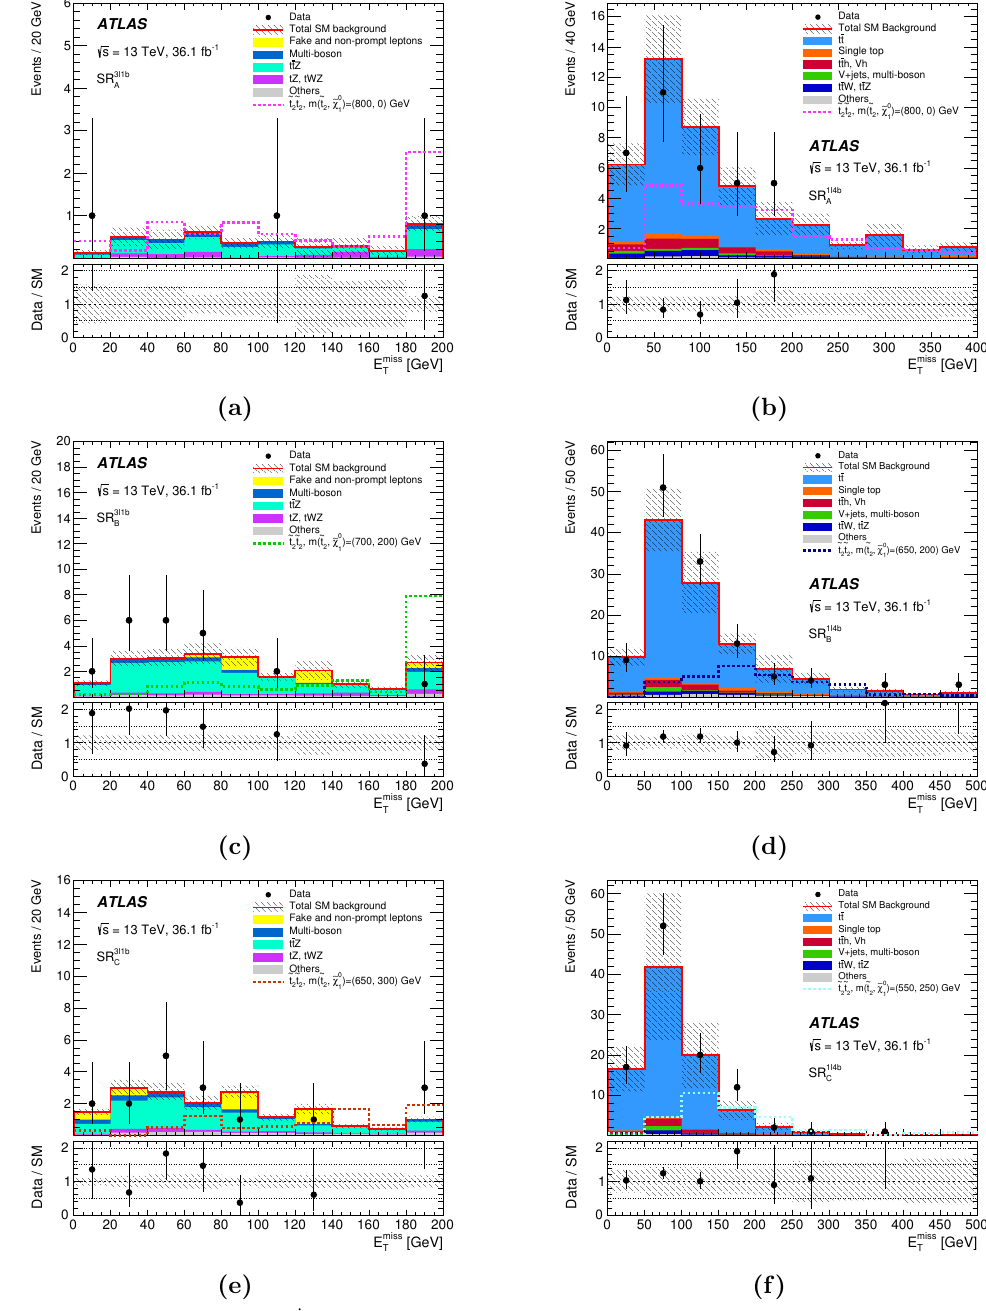
Figure 4. Distribution of E miss for events passing all the signal candidate selection requirements, T except that on E miss , for (a) SR 3 ‘ 1 b , (c) SR 3 ‘ 1 b , (e) SR 3 ‘ 1 b and (b) SR 1 ‘ 4 b , (d) SR 1 ‘ 4 b , (f) SR 1 ‘ 4 b T A B C A B C after the background (cid:12)t described in section 5. The contributions from all SM backgrounds are shown; the bands represent the total uncertainty. The expected distributions for signal models with m (~ t 2 ) = 700 GeV and m (~ (cid:31) 0 1 ) = 0 GeV, and m (~ t 2 ) = 650 GeV and m (~ (cid:31) 0 1 ) = 250 GeV are also shown as dashed lines. The last bin in each (cid:12)gure contains the over(cid:13)ow. The lower panels show the ratio of the observed data to the total SM background prediction, with the bands representing the total uncertainty in the background